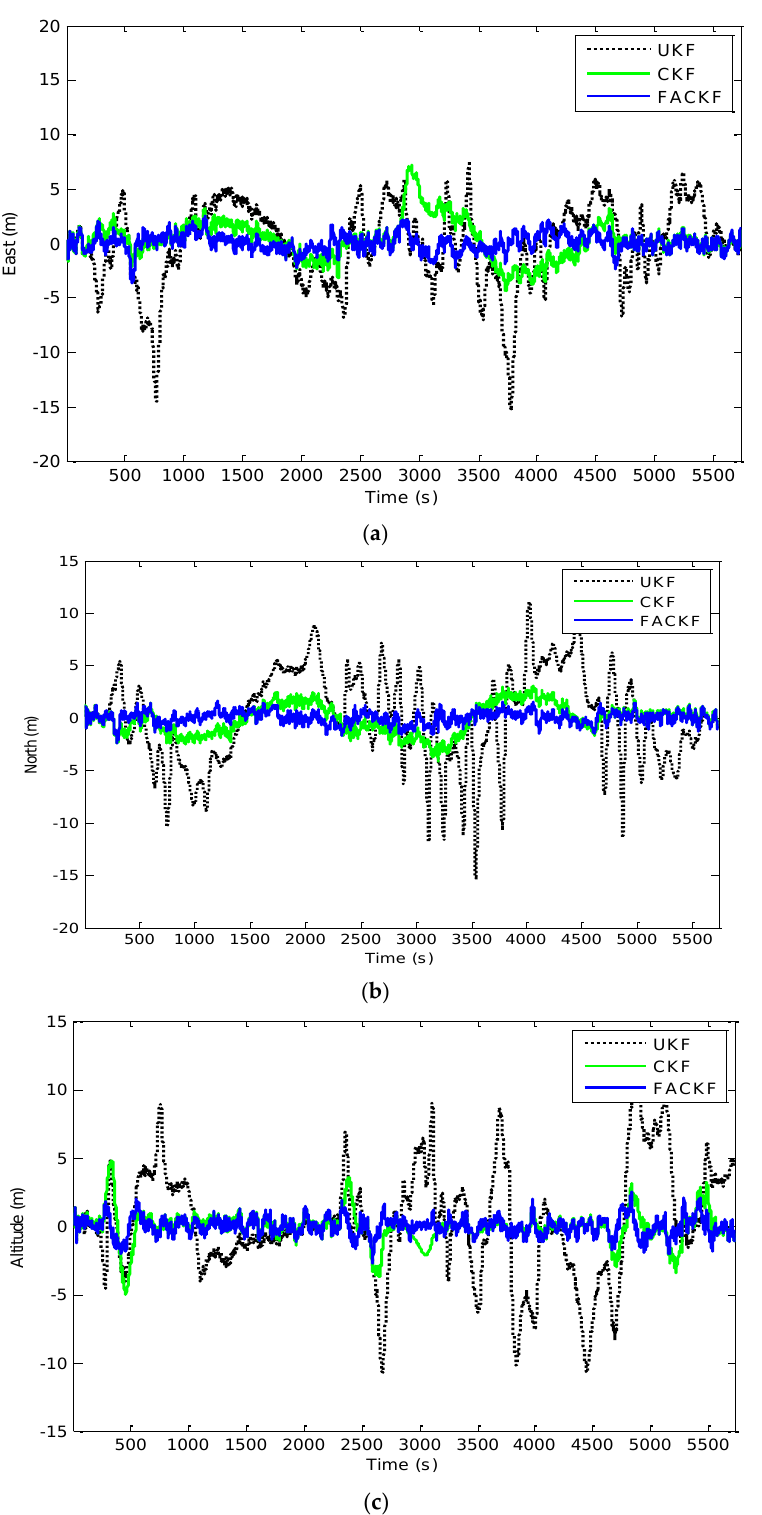
Figure 11. The Euler angles for the case of three-dimensional simulation. ( a ) Roll angle; ( b ) Pitch angle; ( c ) Yaw angle.